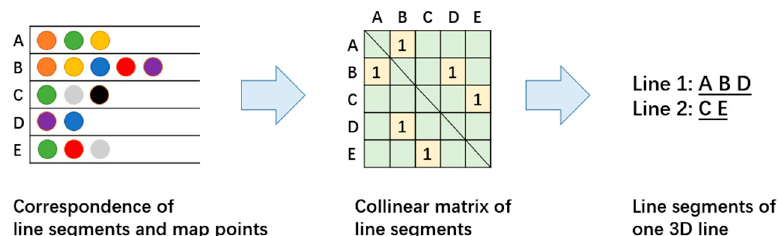
Figure 4. A toy case illustrating the proposed method of matching line segments. On the left is the correspondence of line segments and map points, where A, B, . . . , E represents line segments and colorful balls are points. The collinear matrix in the middle is built from the search and match from the correspondence. From the matrix, we can get the collinear relationship of line segments.